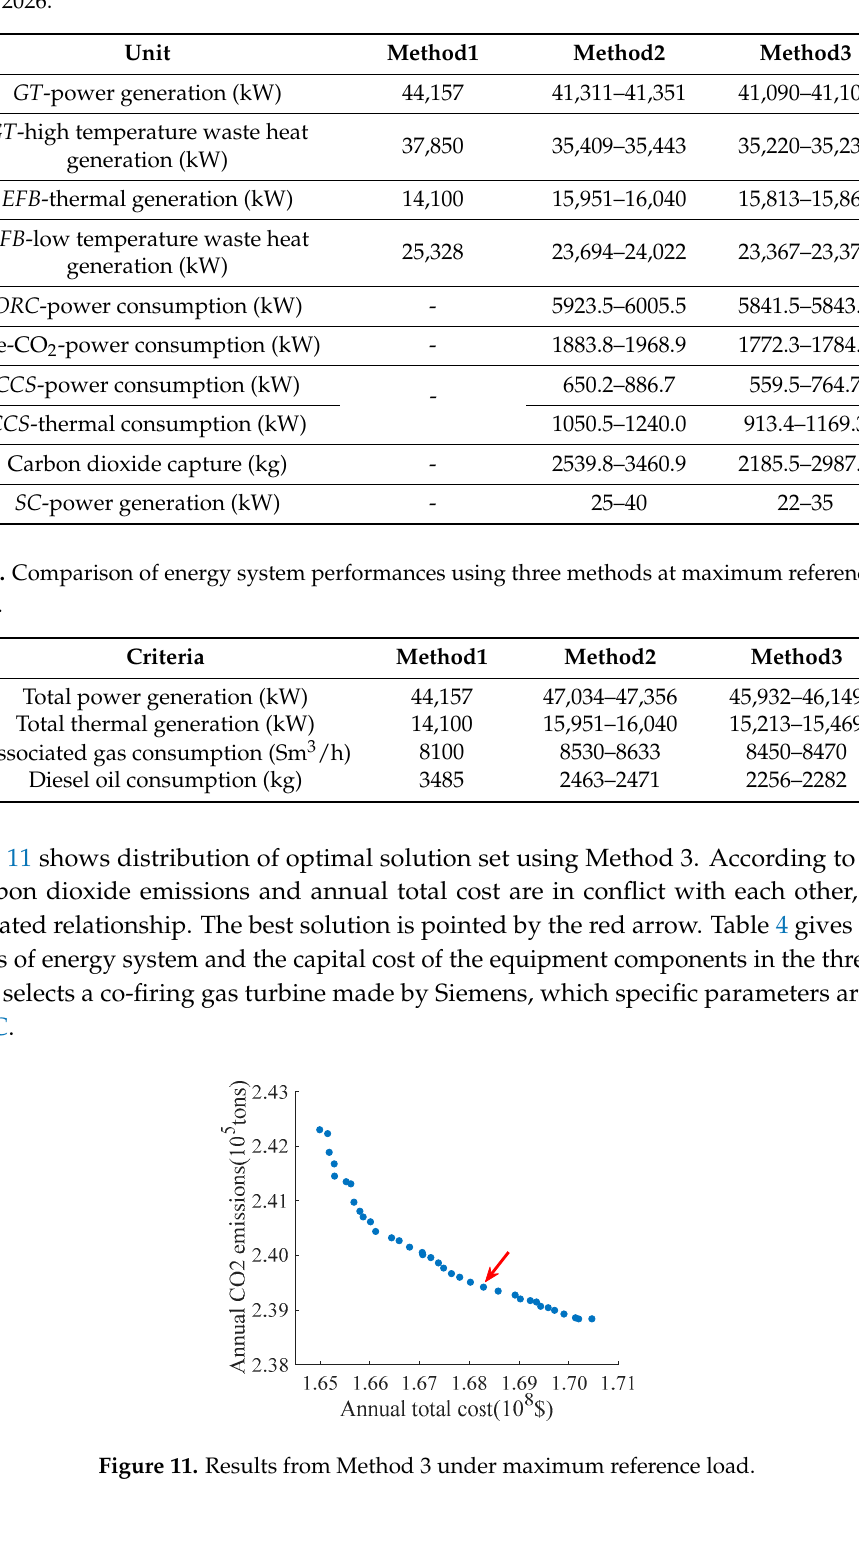
Table 2. Power and heat generation/consumption of units using three methods at maximum reference load in 2026.